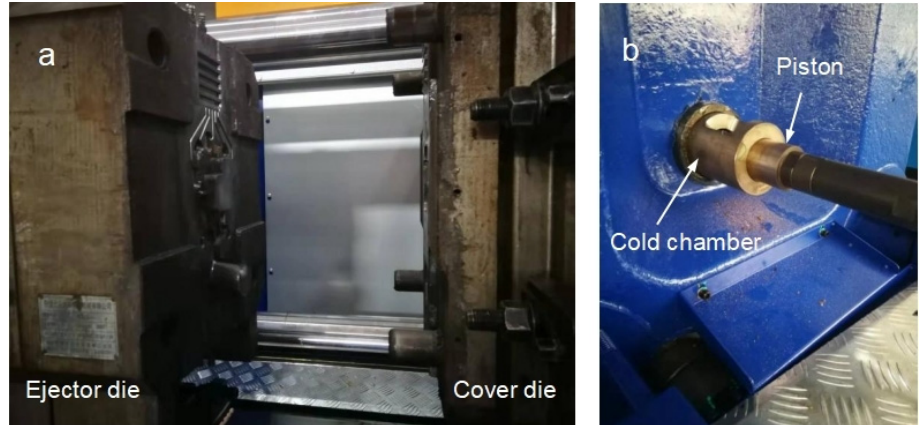
Figure 1. Three-dimensional models of the sample and the corresponding moving die: ( a ) an ashtray style sample and ( b ) components of the moving die.